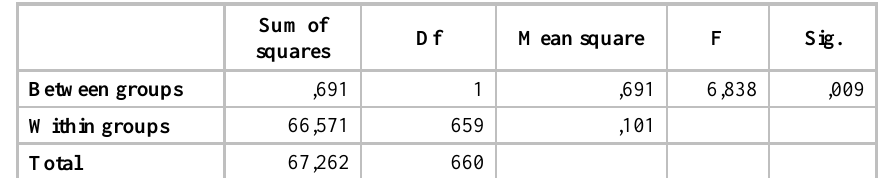
Table 3 . Shopper touch behaviour